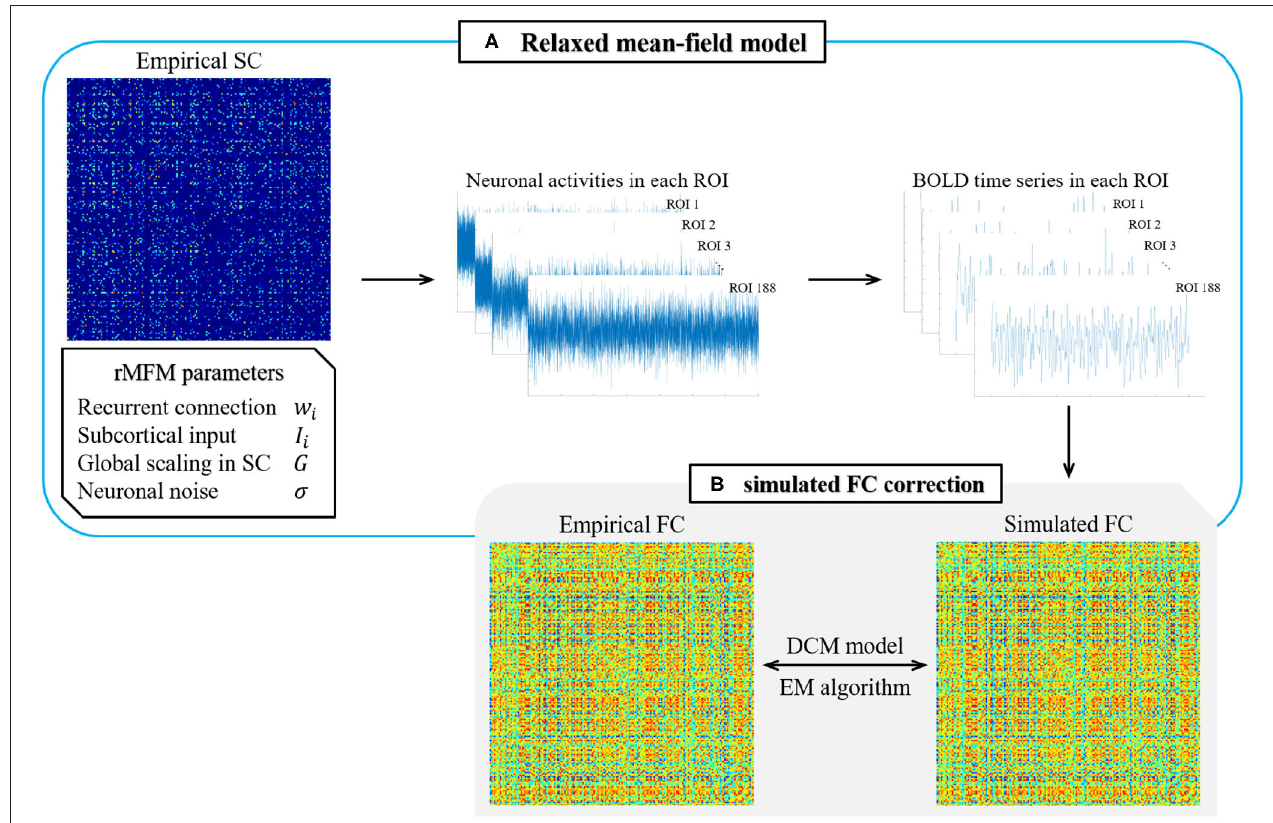
FIGURE 1 | Overview of rMFM & simulated FC correction. (A) Relaxed mean-field model. The empirical SC and initial parameters are given to the relaxed mean-field model to obtain the neuronal activities in each ROI and then input the neuronal activity into the hemodynamic model to obtain the BOLD time series. Calculated the correlation of the BOLD time series to obtain the simulated FC. (B) Simulated FC correction. Using the maximum expectation algorithm in the dynamic causal model to correct the simulated